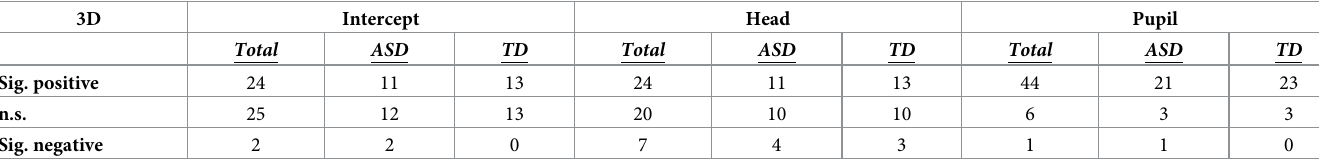
Table 2. Number of individuals with significant effects of intercept, head, and pupils in 3D. 3D Intercept Head Pupil Total ASD TD Total ASD TD Total ASD TD Sig. positive 24 n.s. 3 Sig. negative 2 2